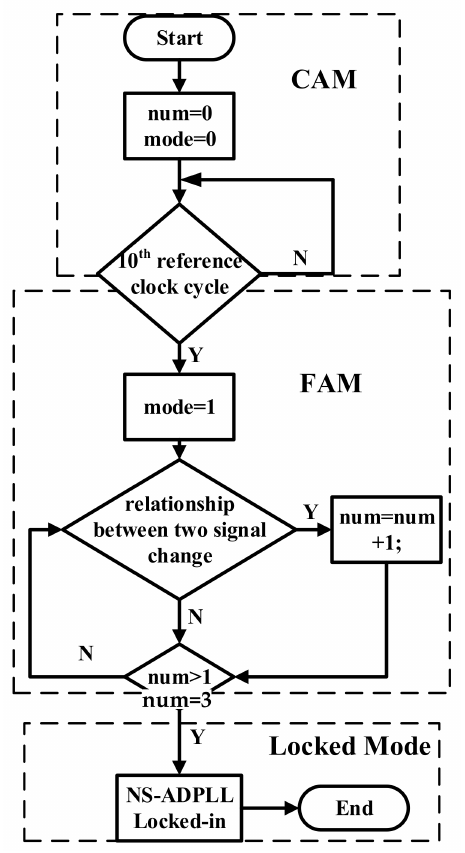
Figure 3. Operating principle of the MA module.